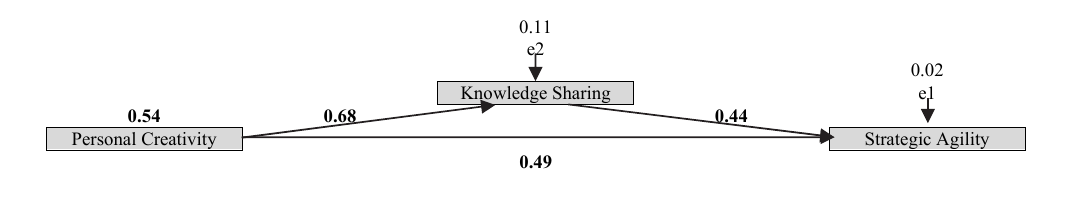
Fig. 3. The results estimated through